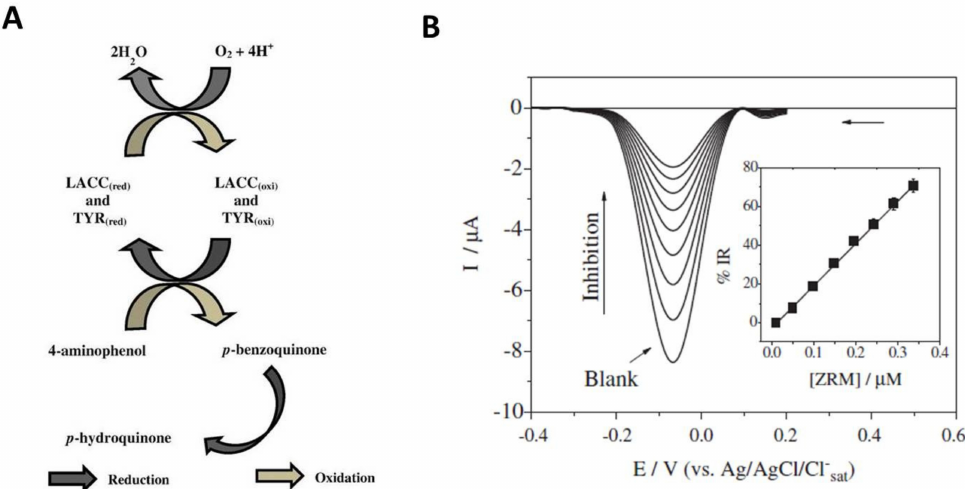
Figure 6. ( A ) Principle of DTF detection with a bi-enzymatic biosensor based on laccase and tyrosinase. ( B ) Magnitude of cathodic currents recorded with the bi-enzymatic biosensor for the reduction of p-benzoquinone to p-hydroquinone by square wave voltammetry, reported in [79]. Reproduced fro [79] with